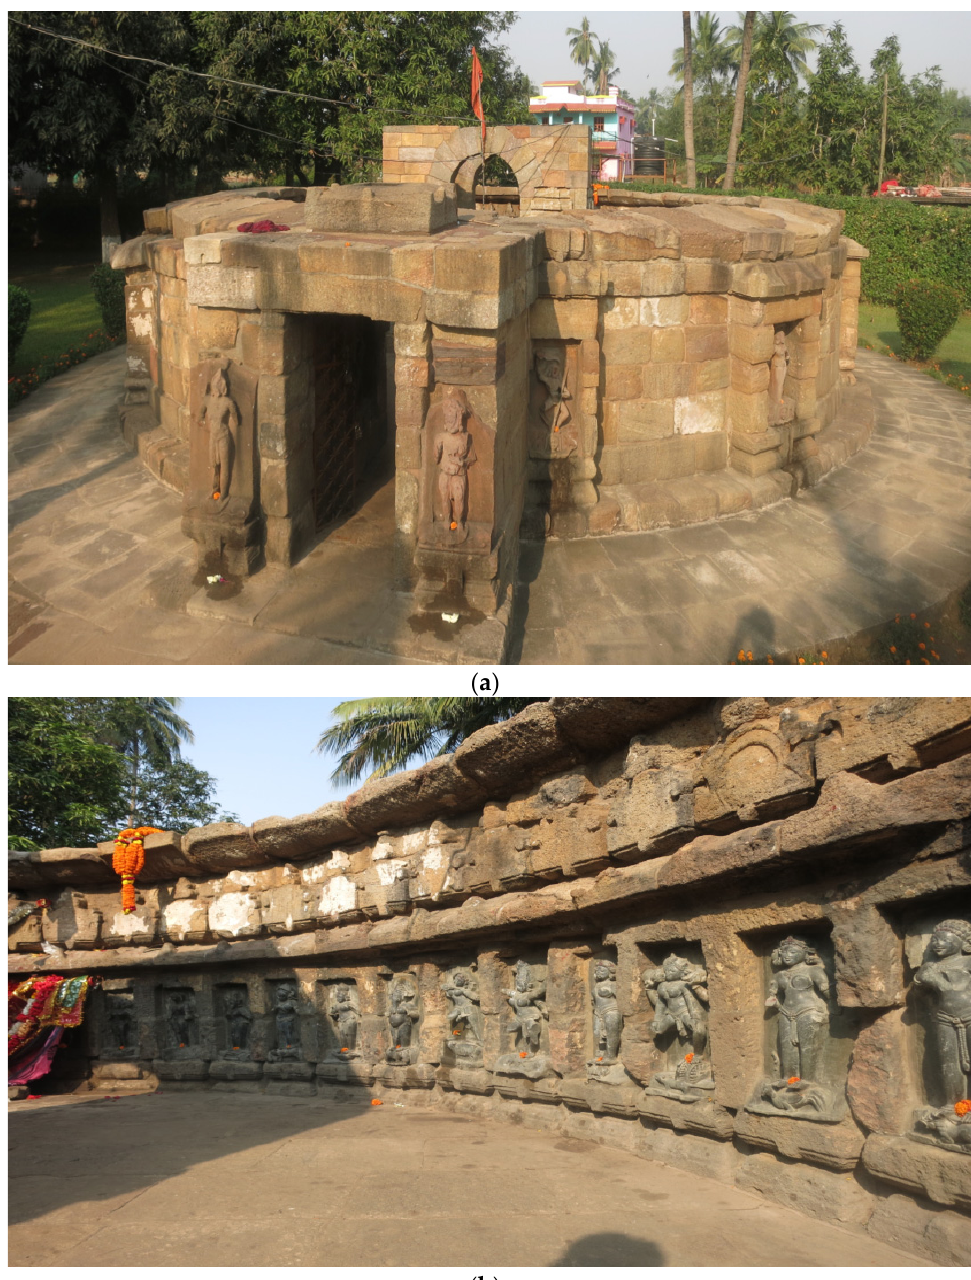
Figure 3. ( a ) Yogini temple, Hirapur, Odisha, ca. mid-9th–early 10th century. Photograph by Katherine E. Kasdorf. ( b ) Yogini temple, Hirapur, view of interior. Photograph by Katherine E. Kasdorf. Even with all their iconographical variety, yogini sculptures from a particular group